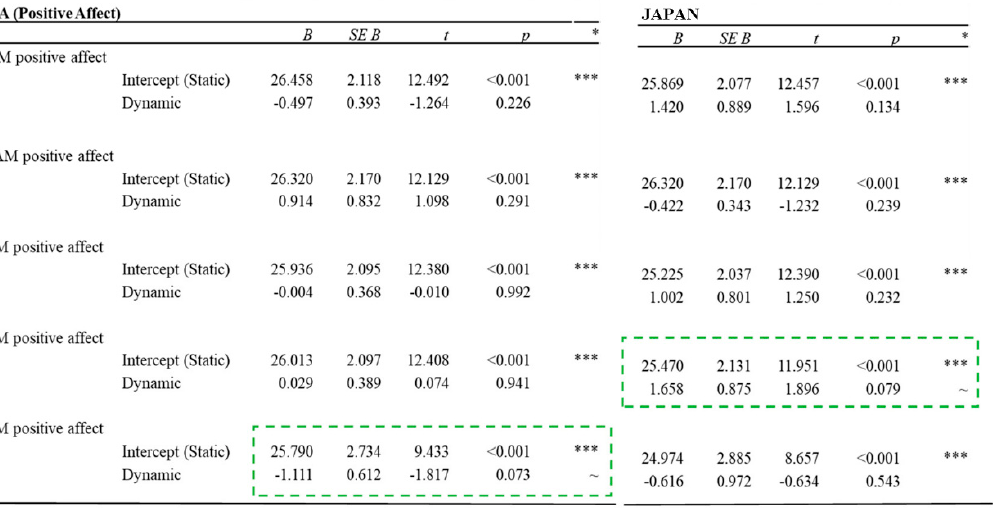
Table 5. Results for the PANAS mood measurements (PA).